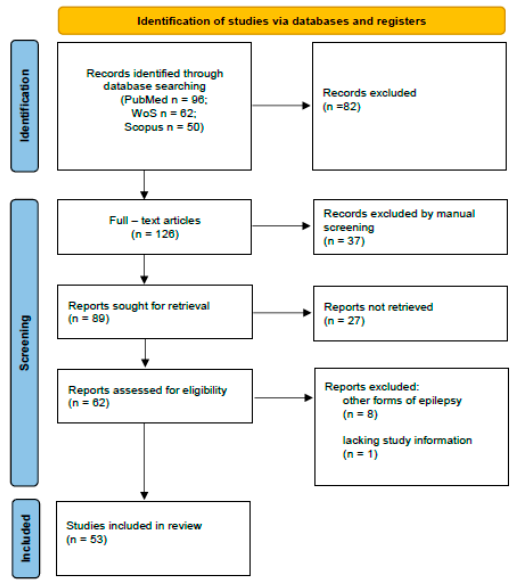
Figure 1. Flow chart diagram visualizing the database searches, number of publications identified, screened, and final full texts included in the present systematic review. screened, and final full texts included in the present systematic